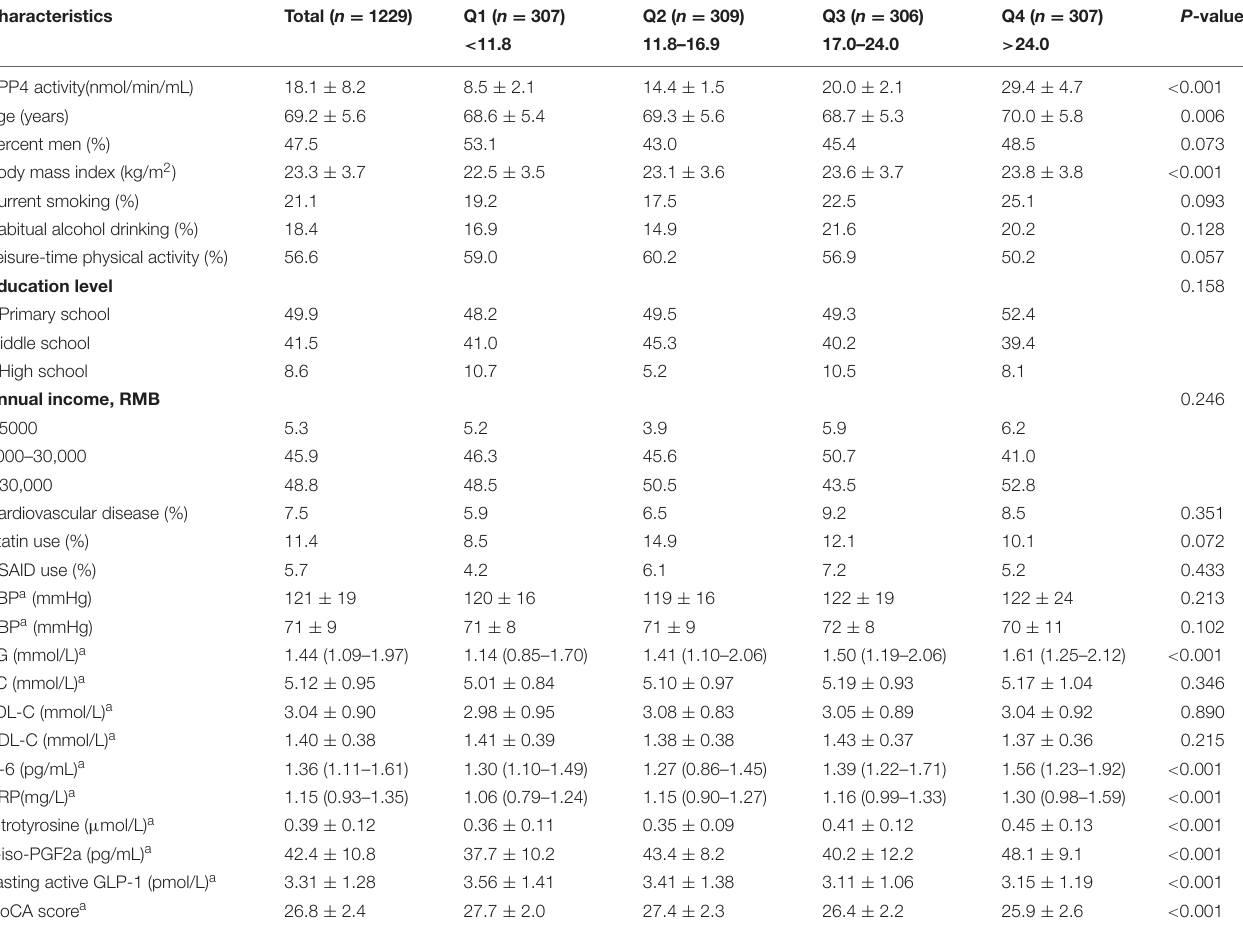
TABLE 1 | Characteristics of study participants according to DPP4 activity